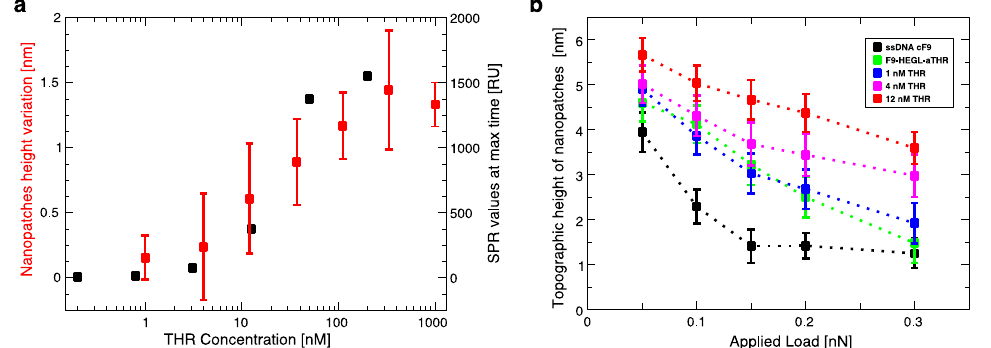
Figure 5. ( a ) Comparison of binding curves obtained from the height variation measured with the AFM on DNA nanopatches (left) and SPR data (right) vs. THR concentration; and ( b ) evaluation of the static compressibility on DNA nanopatches at low concentrations of THR.